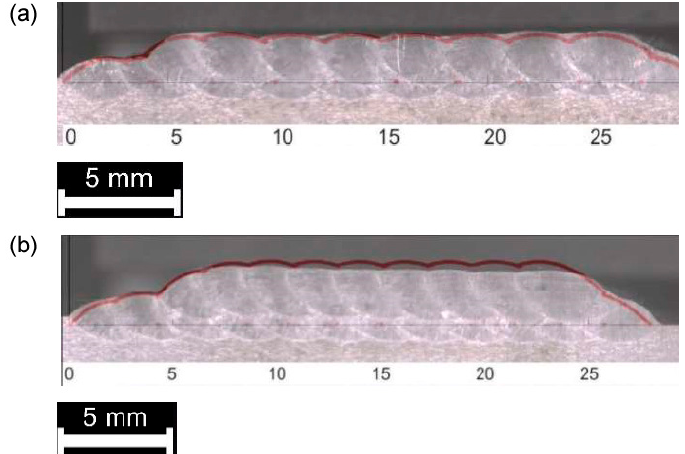
Figure 13. Comparison between theoretical (red, superimposed) and actual profile, multi-track, 2-layer deposition: ( a ) 33% OR ; ( b ) 50% OR .